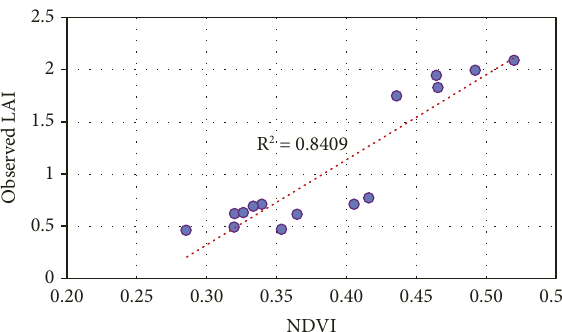
Figure 3: Relationship between observed LAI to NDVI. R 2 = 0.6234